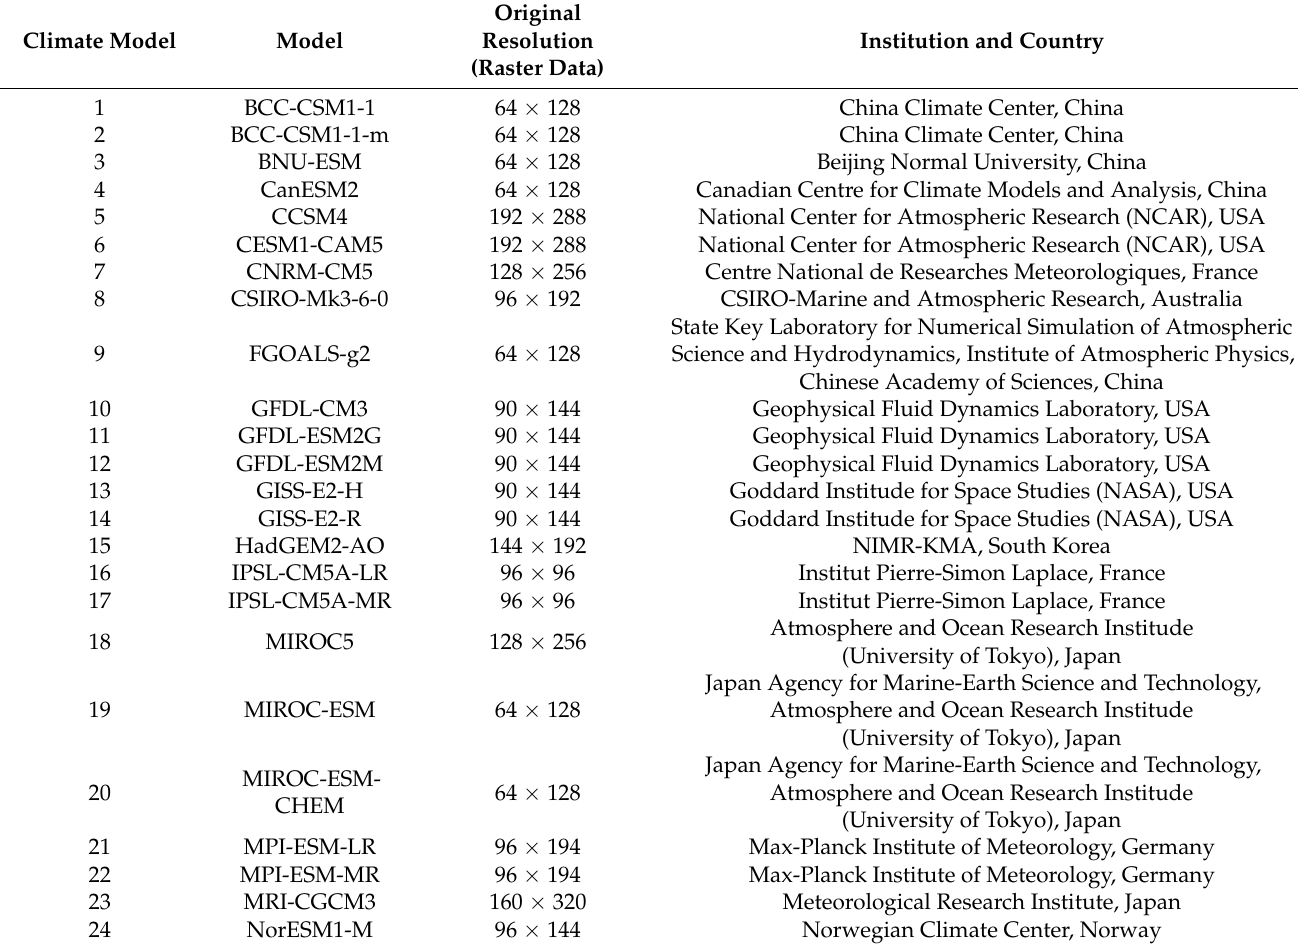
Table 2. Basic information about the 24 climate models in the CMIP5 used in the present